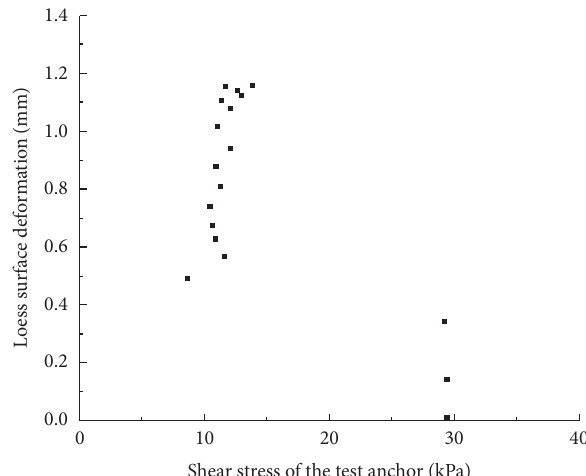
Figure 8: Changing trend between loess surface deformation and shear stress of the test anchor (the 1st).